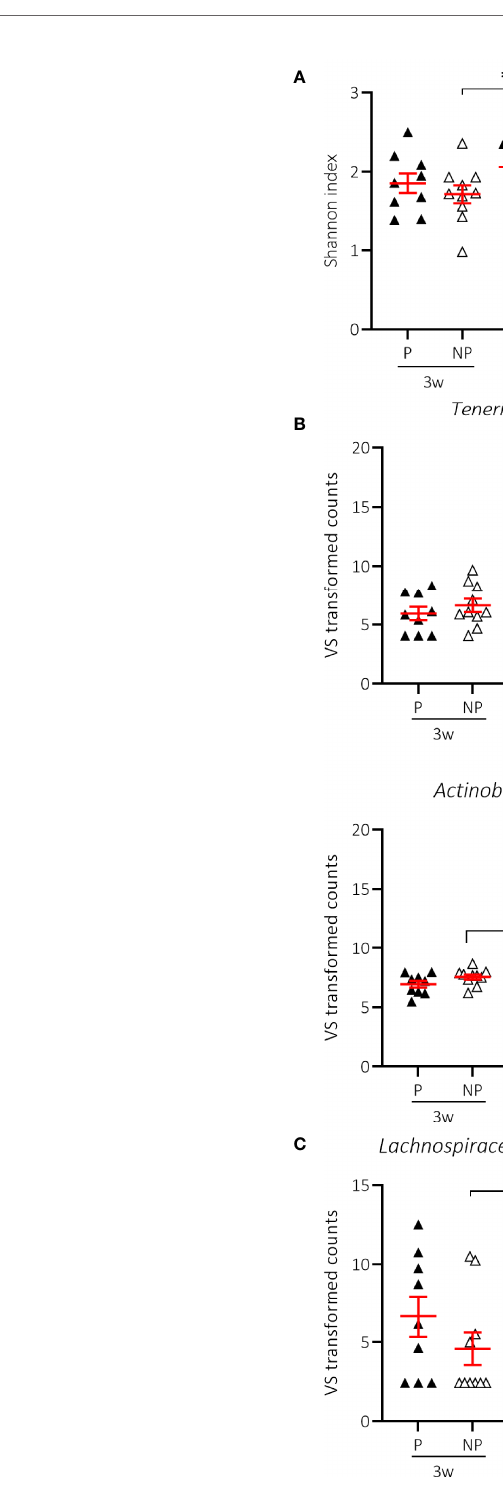
FIGURE 6 | Change in alpha-diversity and taxa abundances of T1D progressor (P) and non-progressor (NP) NOD mice receiving normal chow (NC). Changes in Shannon and Chao1 indices (A) , phyla (B) , and genera (C) are shown for female NOD mice receiving NC and progressing (P) (N = 18 paired samples) or not progressing towards T1D (NP) (N = 20 paired samples). Symbols (N = 4-10) represent individual mice, and the line re fl ects the group mean with SEM. *P ≤ 0.05; **P ≤ 0.01; ***P ≤